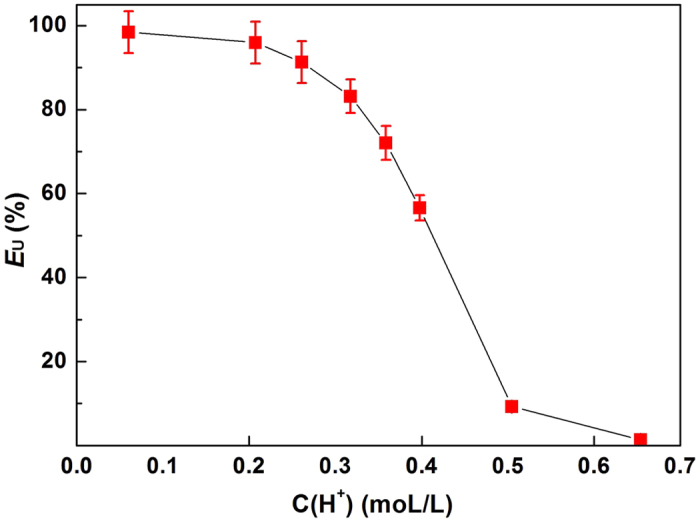
Influence of [H+] on the EU of [HOOCmim][NTf2].